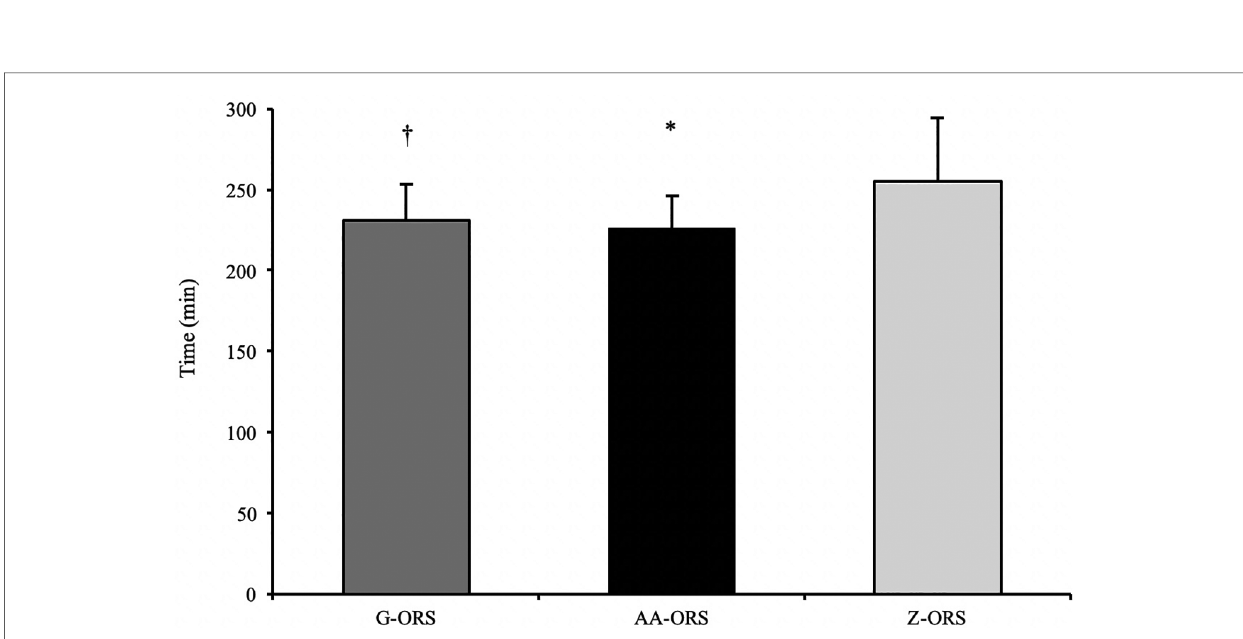
FIGURE 4 Fluid balance data from baseline (Pre) and during the rehydration phase. P <0.05: *, AA-ORS greater vs. Z-ORS; † , G-ORS greater vs. Z-ORS; a , G-ORS different vs. baseline, b , AA-ORS different vs. baseline; c , Z-ORS different vs.